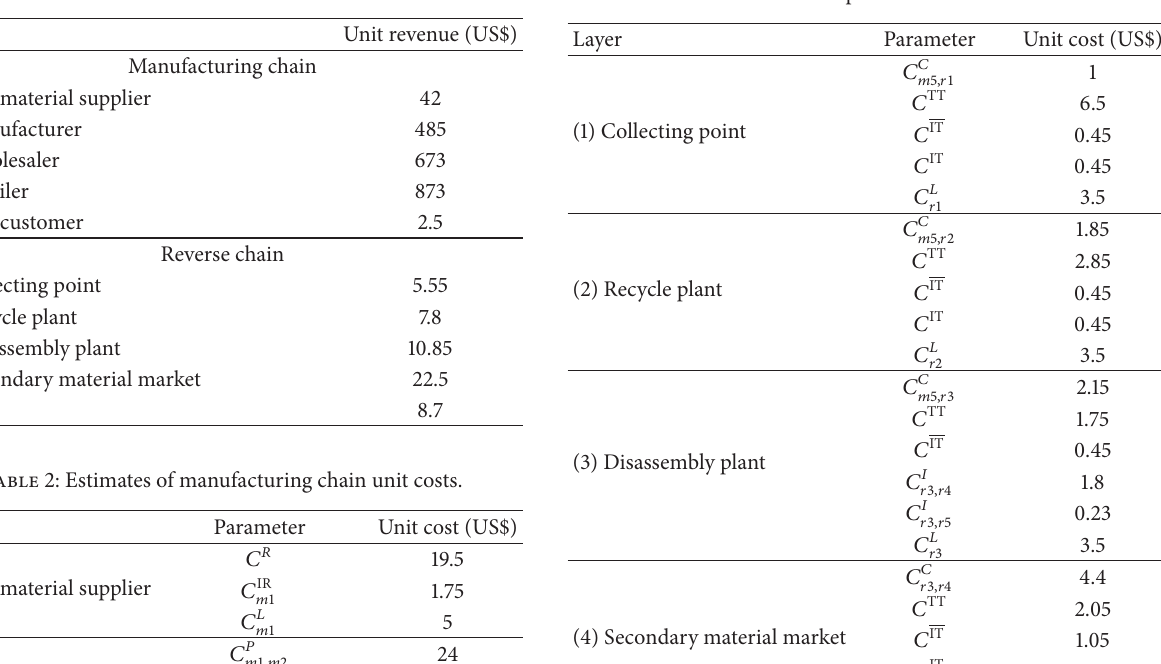
Table 3: Estimates of used-product reverse chain unit